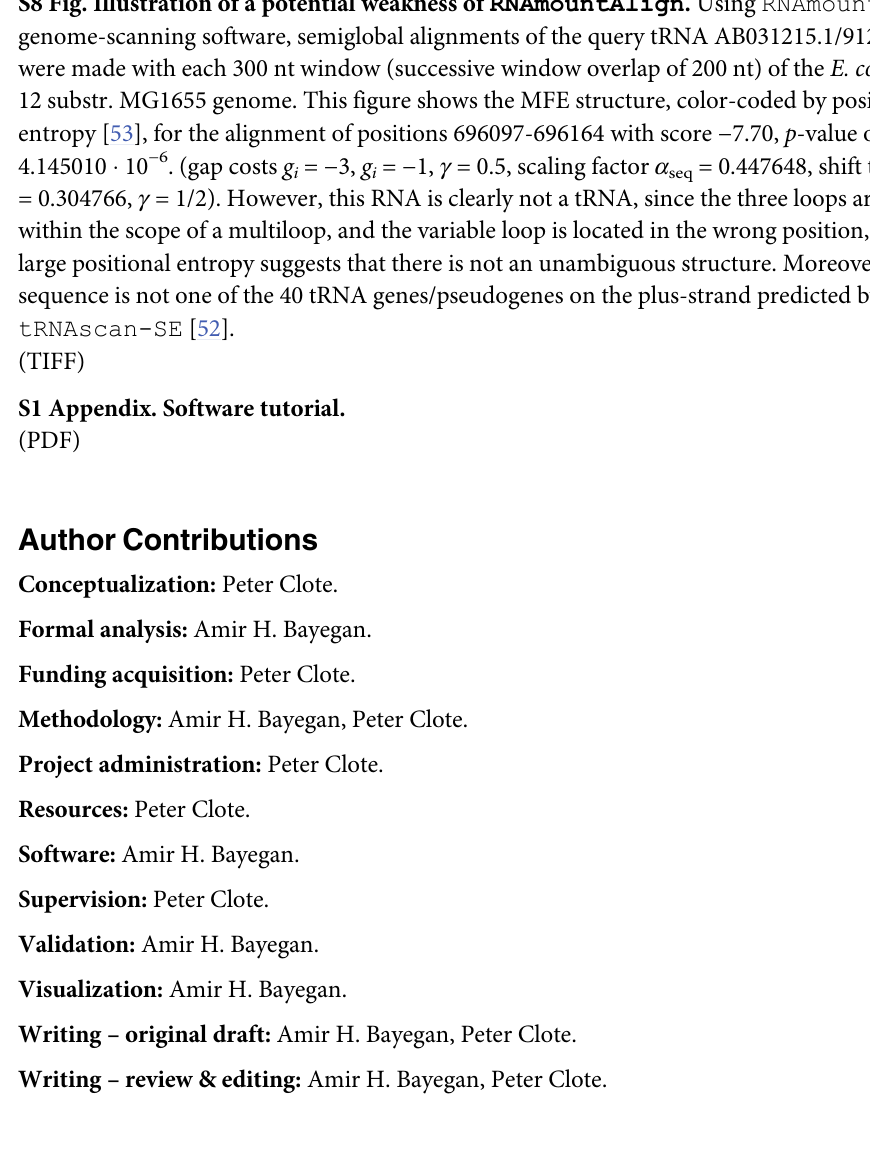
S8 Fig. Illustration of a potential weakness of RNAmountAlign . Using RNAmountAlign genome-scanning software, semiglobal alignments of the query tRNA AB031215.1/9125-9195 were made with each 300 nt window (successive window overlap of 200 nt) of the E. coli str. K- 12 substr. MG1655 genome. This figure shows the MFE structure, color-coded by positional entropy [53], for the alignment of positions 696097-696164 with score − 7.70, p -value of 4.145010 � 10 − 6 . (gap costs g = − 3, g = − 1, γ = 0.5, scaling factor α = 0.447648, shift term α seq str i i = 0.304766, γ = 1/2). However, this RNA is clearly not a tRNA, since the three loops are not within the scope of a multiloop, and the variable loop is located in the wrong position, and the large positional entropy suggests that there is not an unambiguous structure. Moreover, this sequence is not one of the 40 tRNA genes/pseudogenes on the plus-strand predicted by tRNAscan-SE